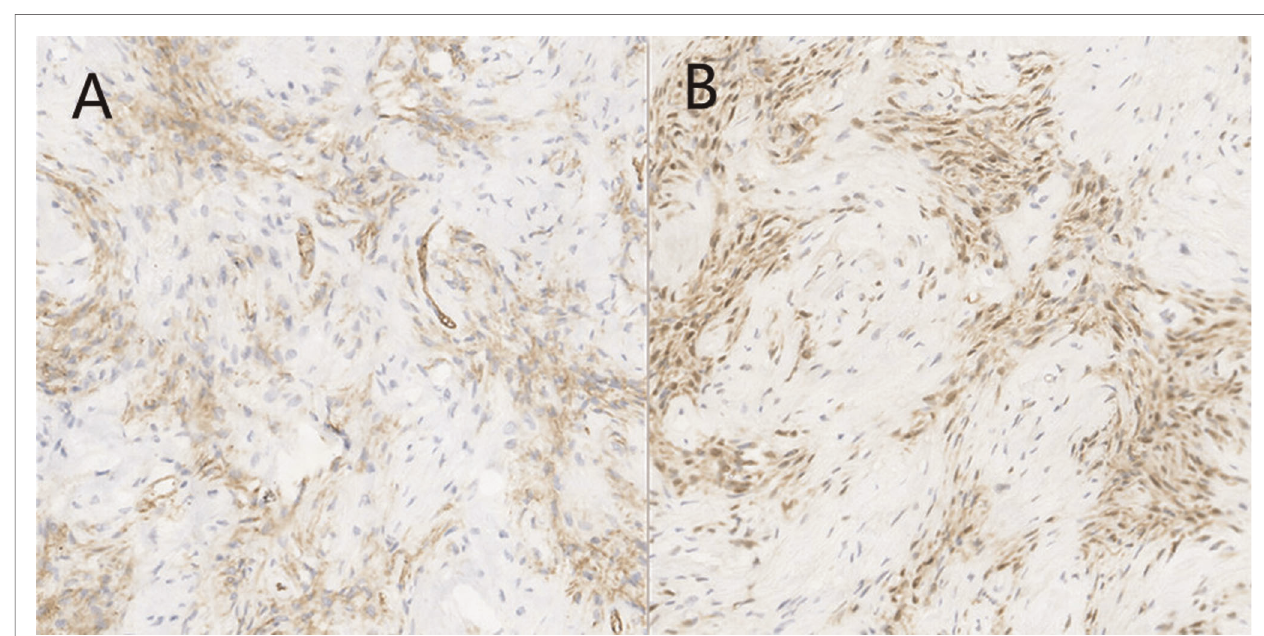
FIGURE 4 | Photomicrograph of pancreatic neuro fi broma. ( A ) Immunohistochemical staining [CD34(+)]. ( B ) Immunohistochemical staining